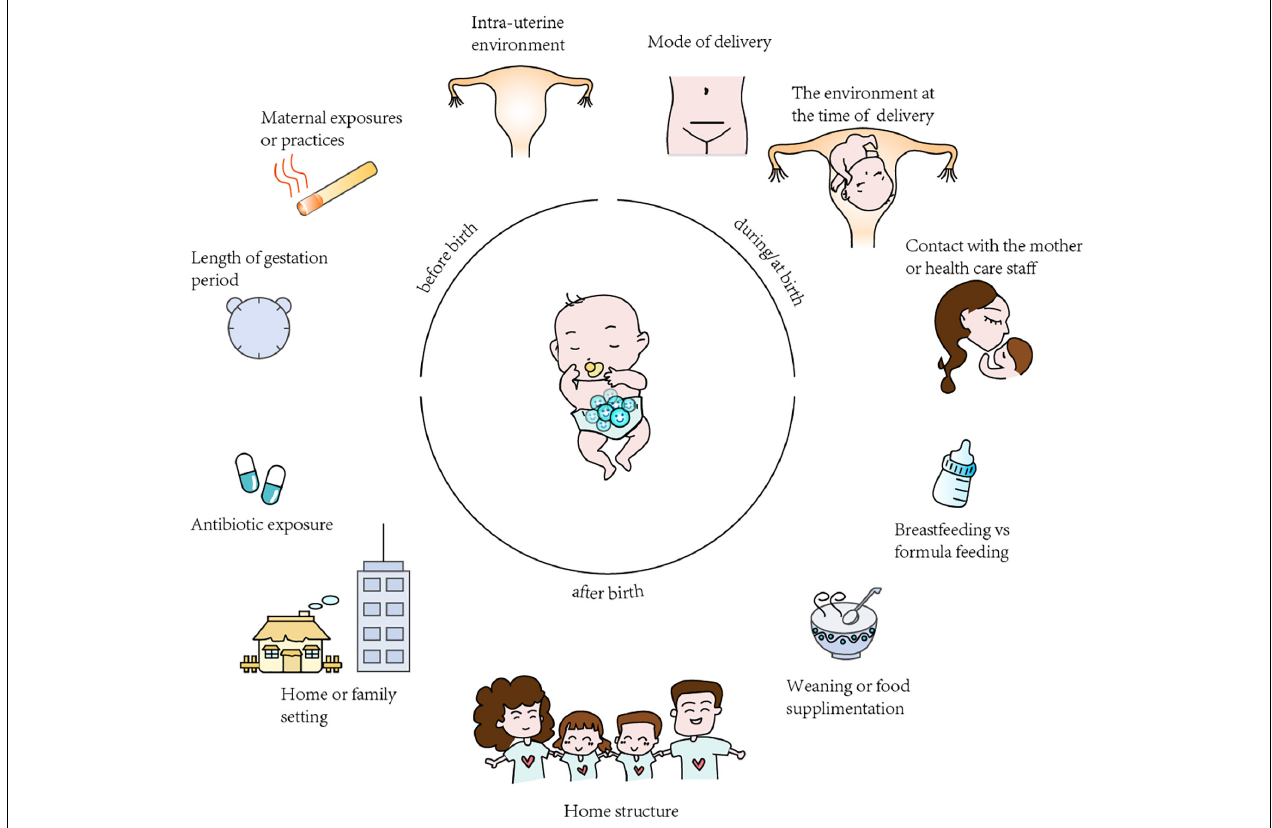
FIGURE 2 | Summary of the factors affecting gut microbiota colonization in infants. The “before birth”, “during birth”, “after birth” factors affecting analysis and results in microbiota